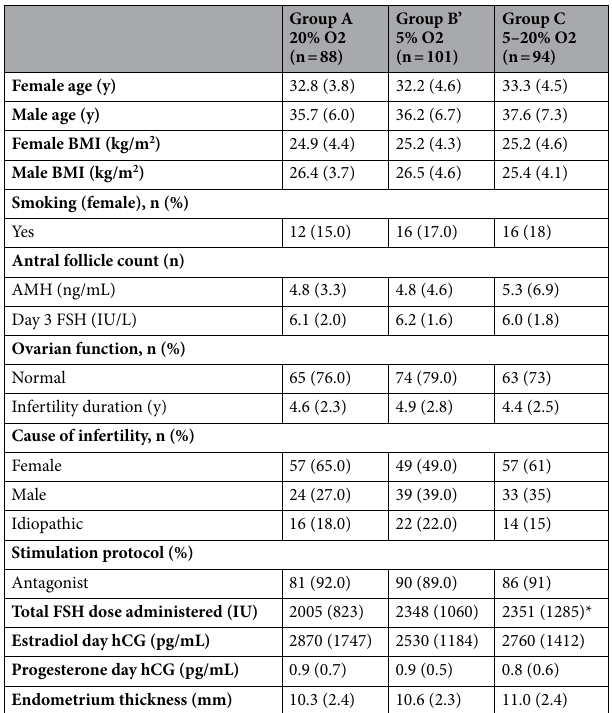
Table 2. Demographic and clinical characteristics of patients randomized at Day 2 (included in« blastocyst analysis »). Data are presented as mean (SD) or n (%). *Global P -value <